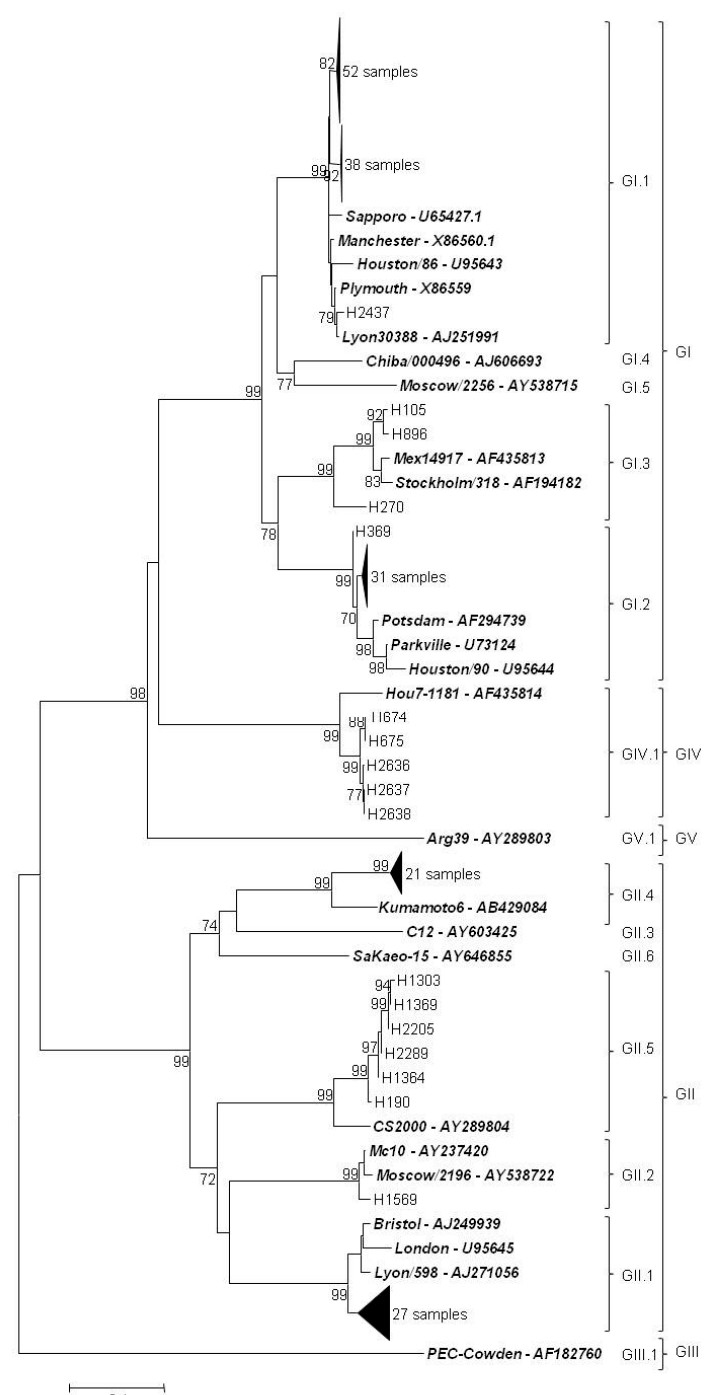
Figure 5. Phylogenetic tree based on the partial capsid gene sequences of SaV using the neighbor-joining algorithm. Bootstrap values (greater than 70%) are shown at each node as percentages of 1000 replicates. Reference sequences are in boldface italics. Porcine enteric calicivirus (Cowden) classified as GIII was used as outgroup. GenBank accession numbers of the reference strains used are detailed in the tree. Bar: Nucleotide substitutions per site.